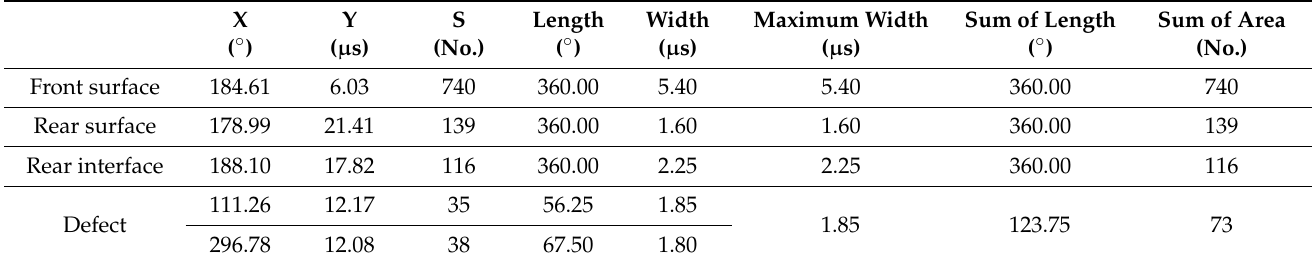
Table 1. Geometric feature information of selected small crack defect image.